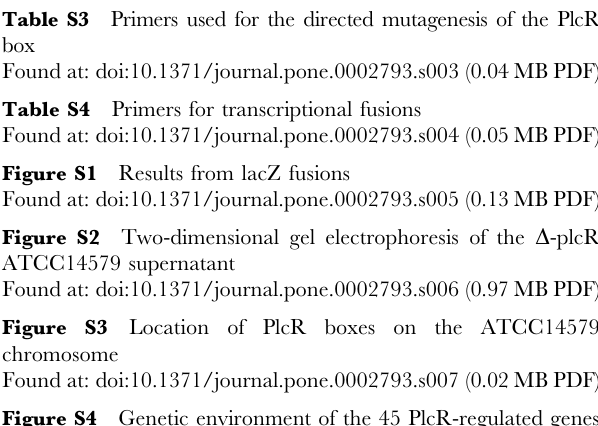
Figure S5 Putative 2 10 s A boxes located downstream of PlcR boxes for PlcR-controlled genes Found at: doi:10.1371/journal.pone.0002793.s009 (0.60 MB